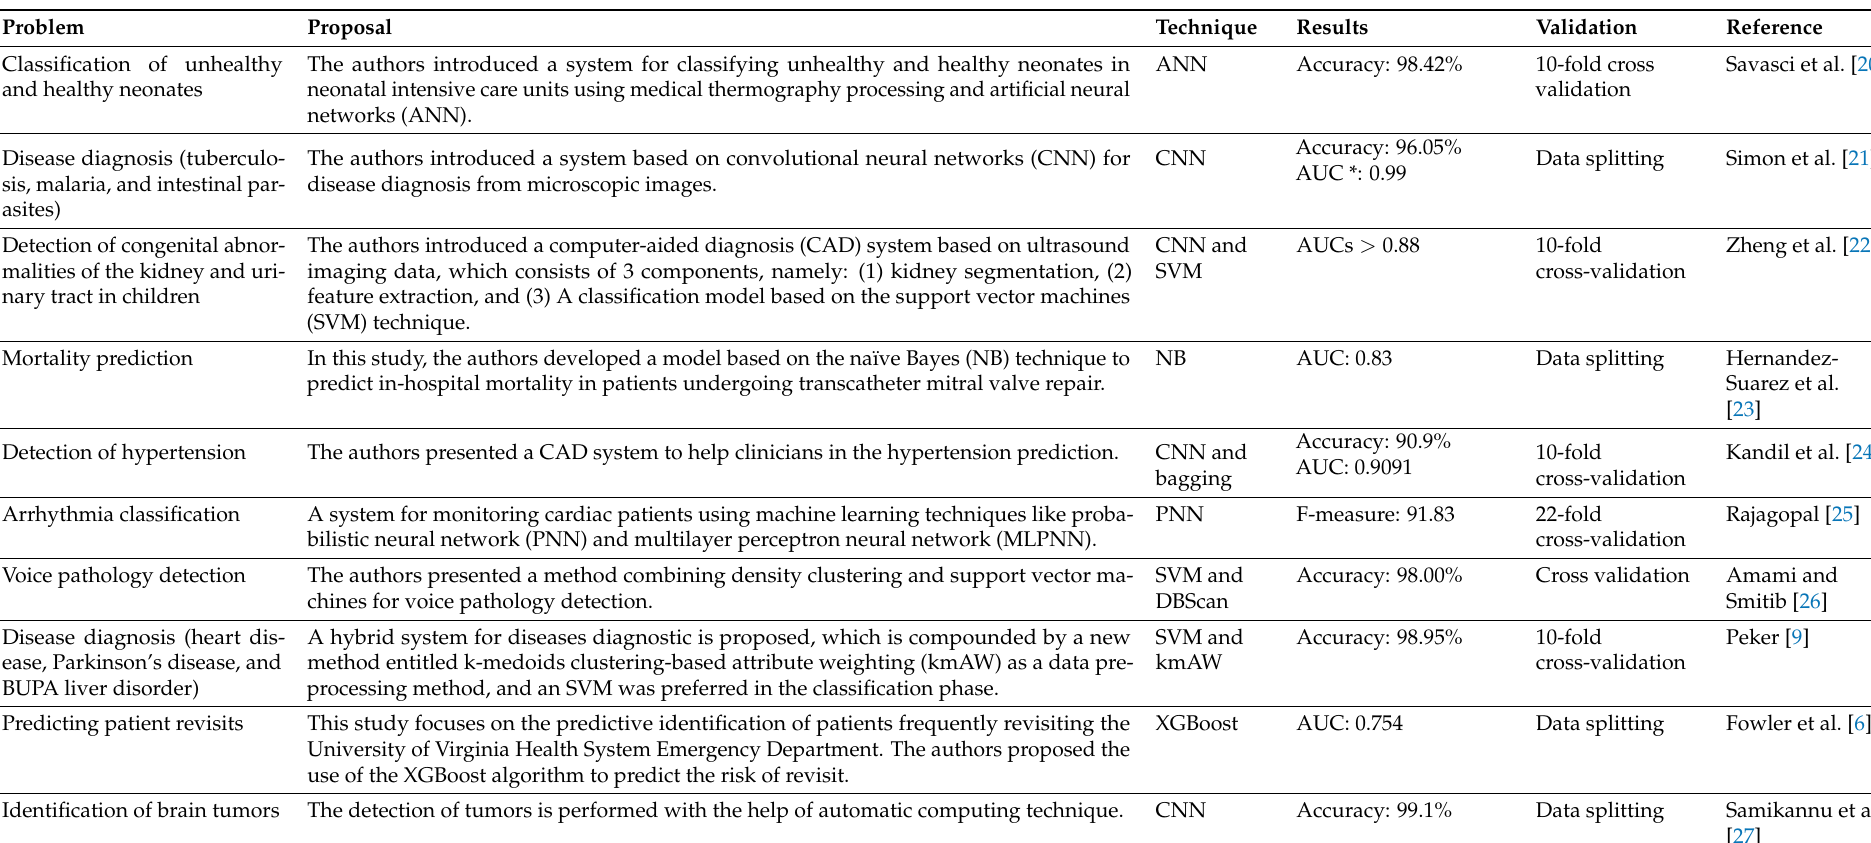
Table 1. Representative publications that report the use of machine learning approaches for medical